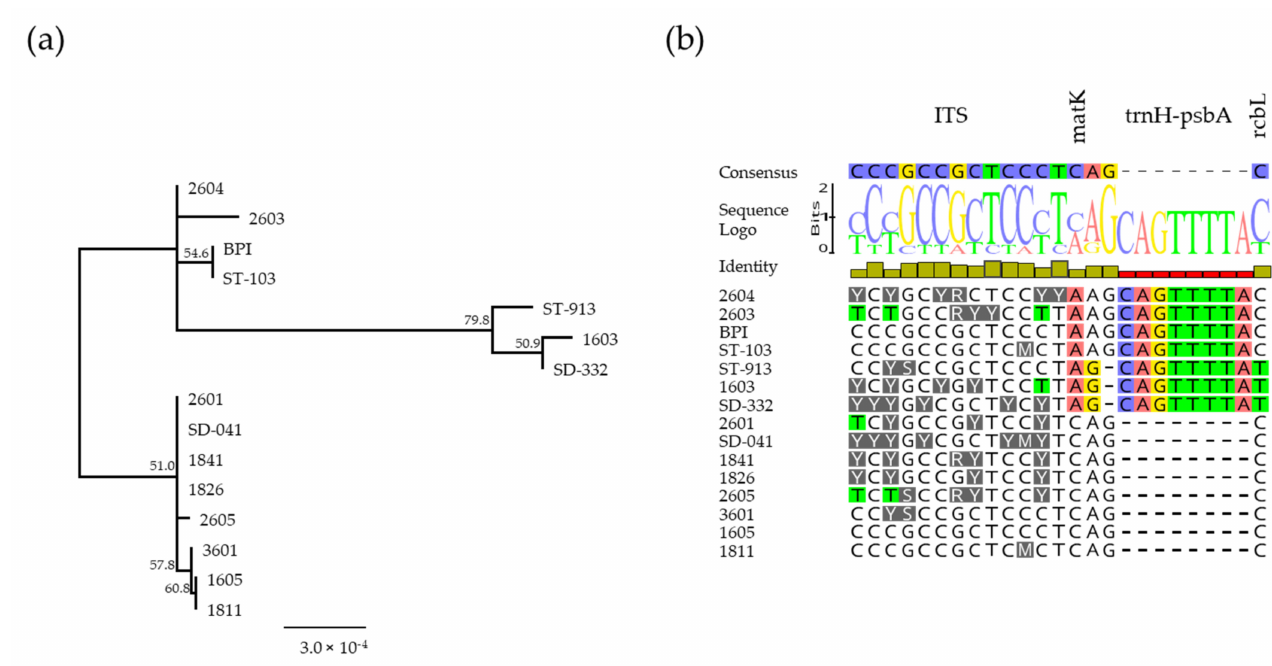
Figure 3. ( a ) Neighbour Joining tree based on the polymorphic sites among ITS nuclear region, and matK, trnH-psbA and rbcL chloroplast barcoding regions. Bootstrap values are reported. ( b ) LOGO representation of polymorphic sites identified among the 15 Lavandula accessions analysed for the DNA